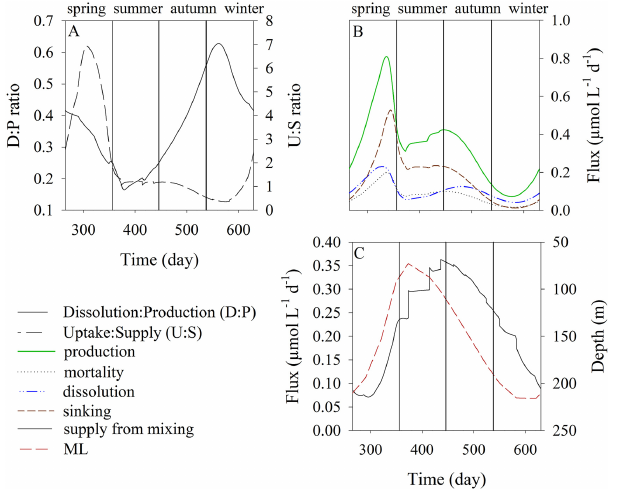
Fig. 7. Evolution of the main fluxes and ratios in the basic model run (with neither basalt input nor fractionation during biogenic silica dissolution); (A) variation of the ratio of Dissolution to Production and of the Uptake to Supply ratio during the year; (B) evolution of production, mortality, dissolution and sedimentation fluxes; (C) evolution of the DSi supply and the ML depth throughout the year.